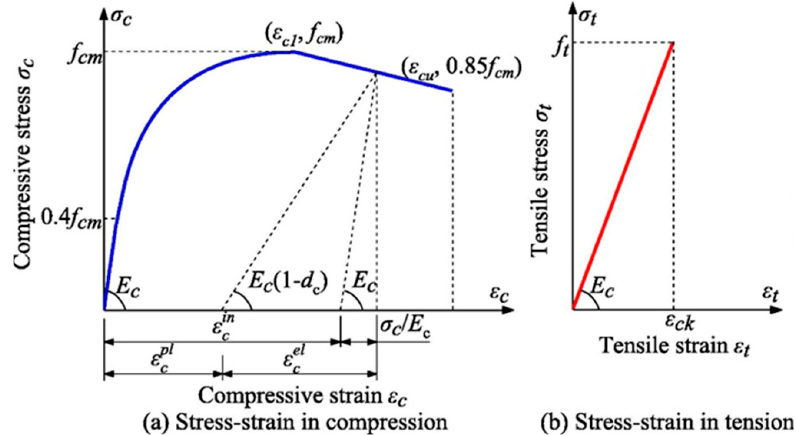
Figure 20. Material constitution of concrete.